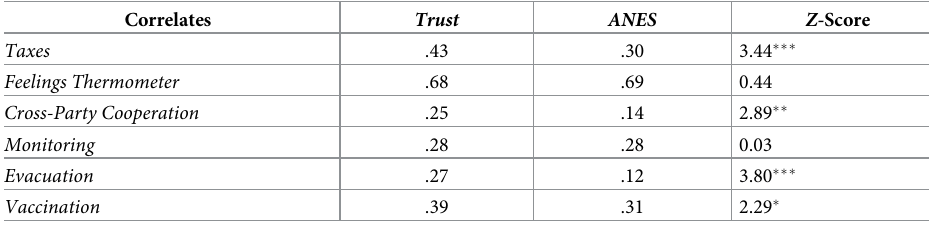
Table 5. Significance of difference in zero-order